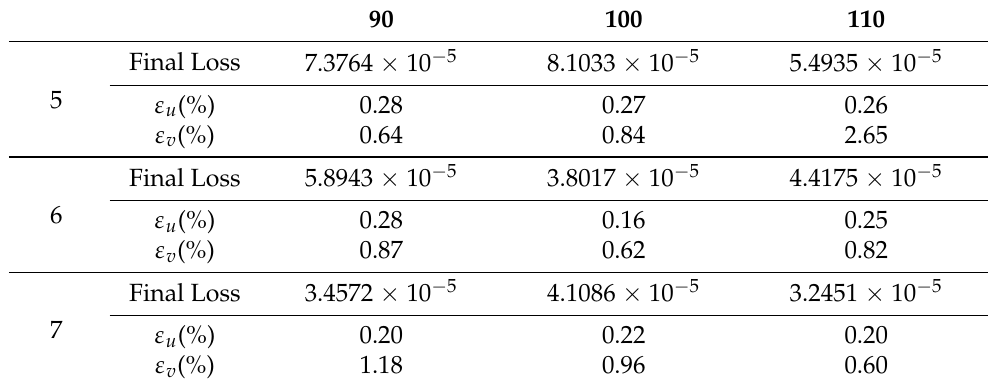
Table 2. Final loss and velocity error obtained in nine DNNs with different